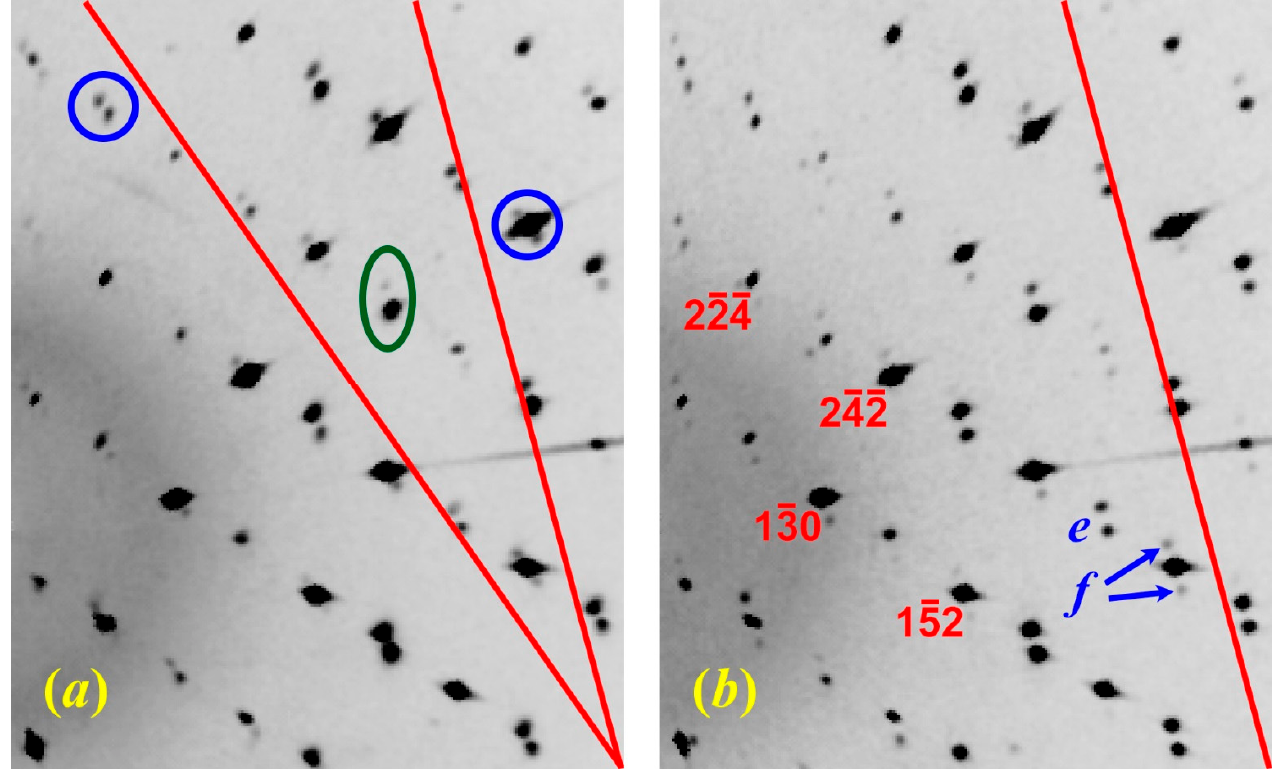
Figure 10. Unwarped hk 3 h + k precession images (equivalent to the [311] zone-axis pattern in Figure 1) of the red-iridescent ( a ) and blue-iridescent ( b ) crystals of sample Gem118. The modulation vectors in the red Gem118 (left) show two different orientations. One has a smaller tilt angle similar to that of the blue sample, represented by the e -reflections marked by the green ellipsoid. The other has a much larger tilt angle and smaller separation, represented by the e - and f -reflections marked by the blue circles. Unprocessed diffraction frames showing the split e -reflections can be found in Figure S14.